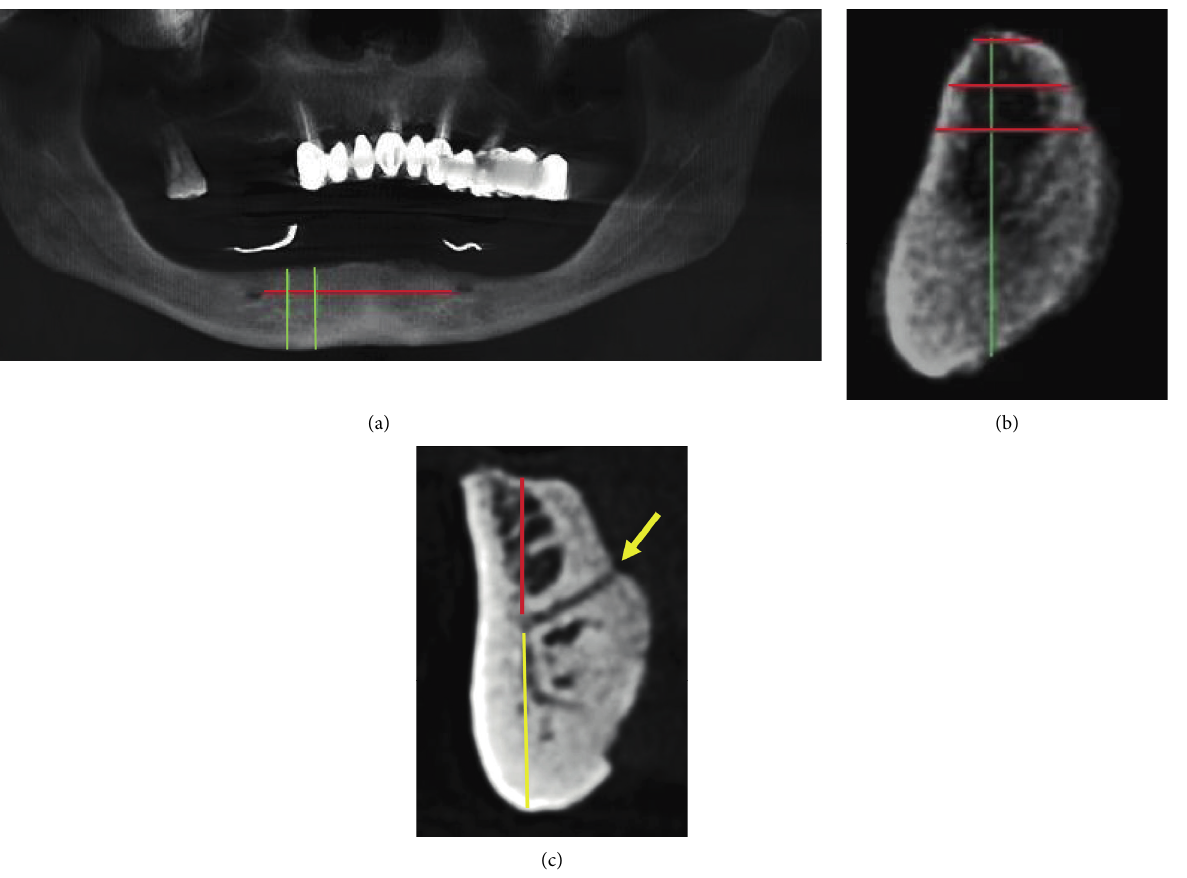
Figure 1: (a) Panoramic view of intermental foramina distance. (b) Vertical bone height in a cross-sectional view and buccolingual thickness at three levels in a cross-sectional view. (c) Red line, distance from the alveolar crest to the base of the lingual canal. Yellow line, distance from the base of the lingual canal to the base of mandible. Arrow shows the orifice of lingual foramen and length of the lingual canal from the orifice to the base of the lingual